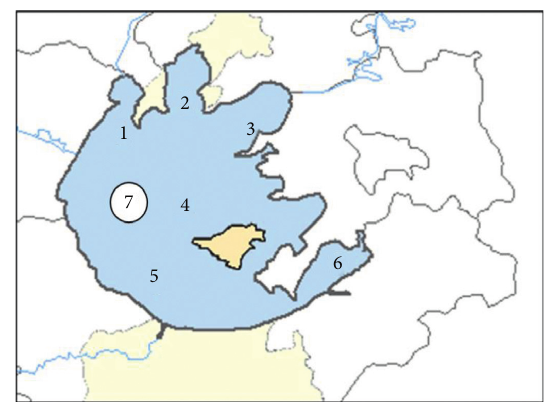
Figure 1: Spatial zoning in Lake Taihu. Area 1: Zhushan bay; area 2: Meiliang bay; area 3: Gonghu; area 4: middle part; area 5: south part; area 6: southeast part; area 7: the whole